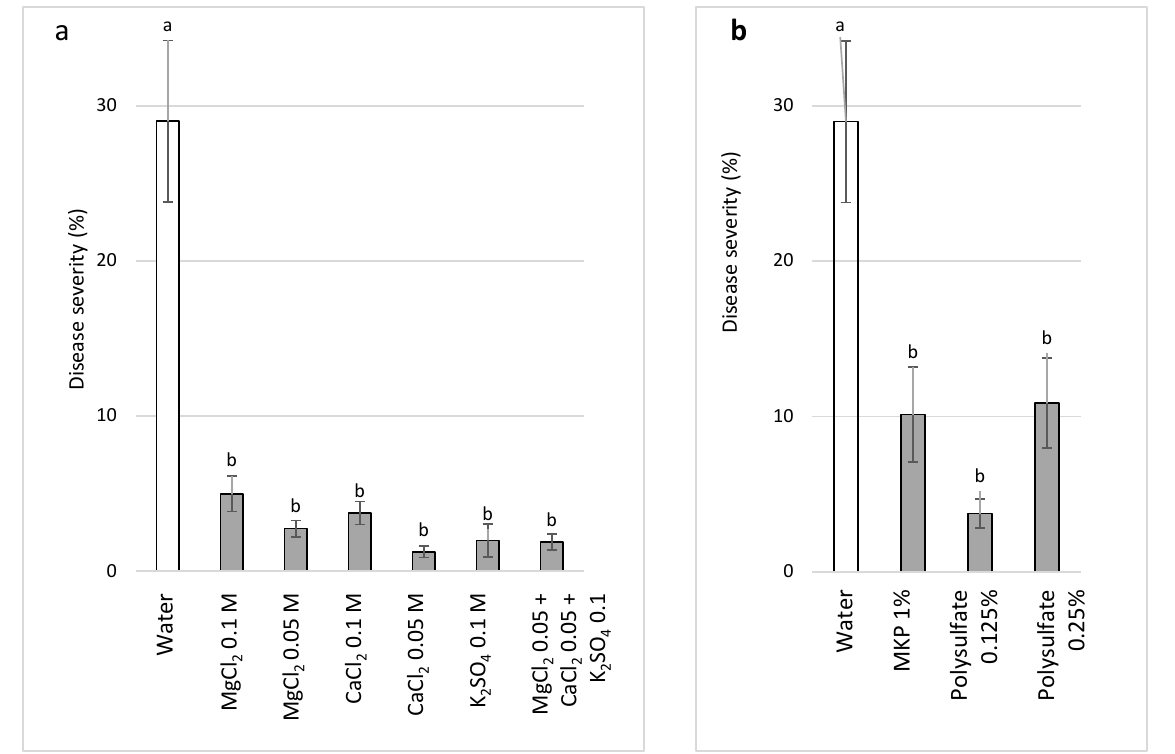
Figure 10. Effect of bi-weekly sprays of ( a ) various salts at two concentrations, individually and in combination (MgCl 2 0.05 M (Cl), CaCl 2 0.05 M (Cl), and K 2 SO 4 0.1 M (SO 4 )) (Expt. A-SCs-b), and ( b ) polyhalite and monopotassium phosphate (Expt. A-SCs-b) on cucumber downy mildew (CDM, Pseudoperonospora cubensis ) at 61 days after planting. CDM severity was evaluated on a 0 to 100% scale, where 0% = no disease symptoms and 100% = leaf fully covered by symptoms. Values for each date and in each graph followed by a common letter are significantly not different from each other according to one-way ANOVA with Tukey’s HSD ( p ≤ 0.05). Bar s = SE.